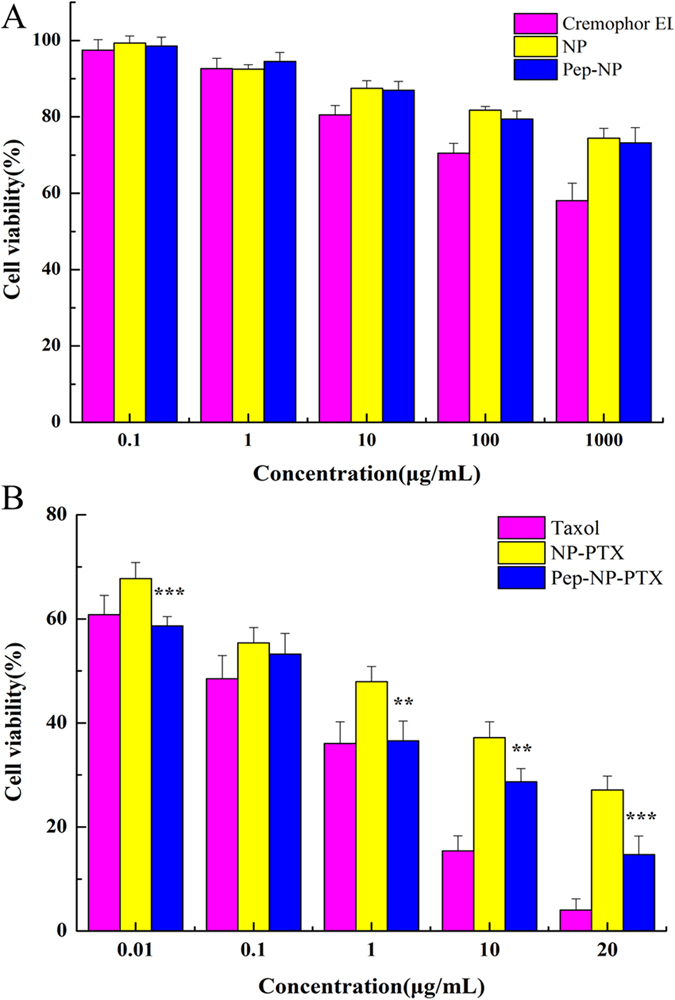
In vitro viability of C6 cells of Cremophor EL and blank nanoparticles at concentration ranging from 0.1 to 1000 μg/mL at 72 h (A); In vitro cytotoxicity of Taxol® and PTX-loading nanoparticles at various concentrations at 72 h (B). Data represented mean ± SD (n = 3). **p < 0.01, ***p < 0.001 significantly lower than that of NP-PTX.